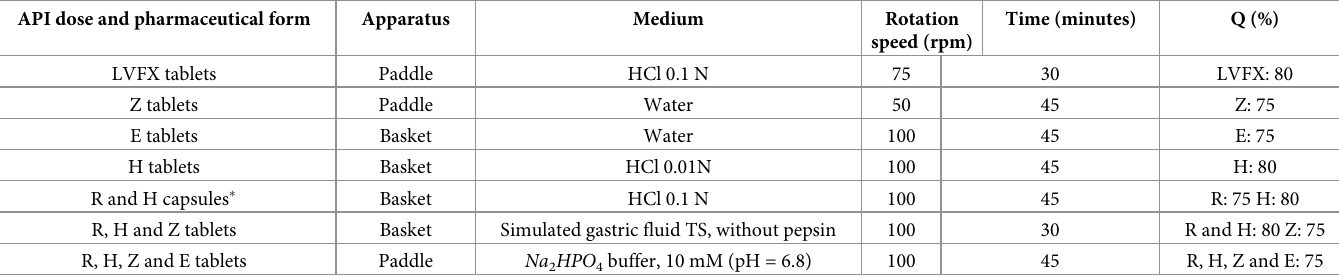
Table 2. Conditions for each dissolution